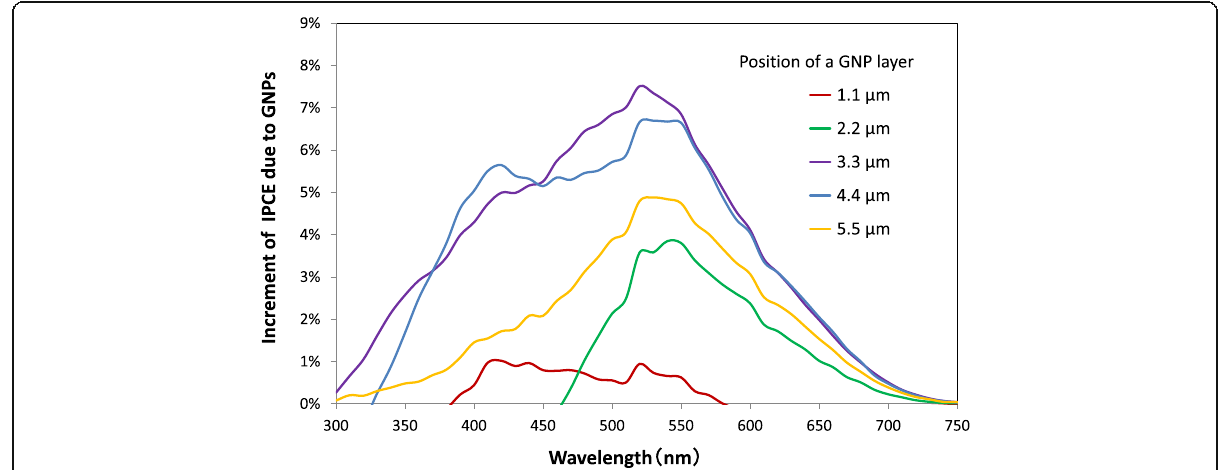
Fig. 11 Increment of IPCE due to GNPs with varying the position of a GNP layer. The density of GNPs is 2.7 μ g/cm 2